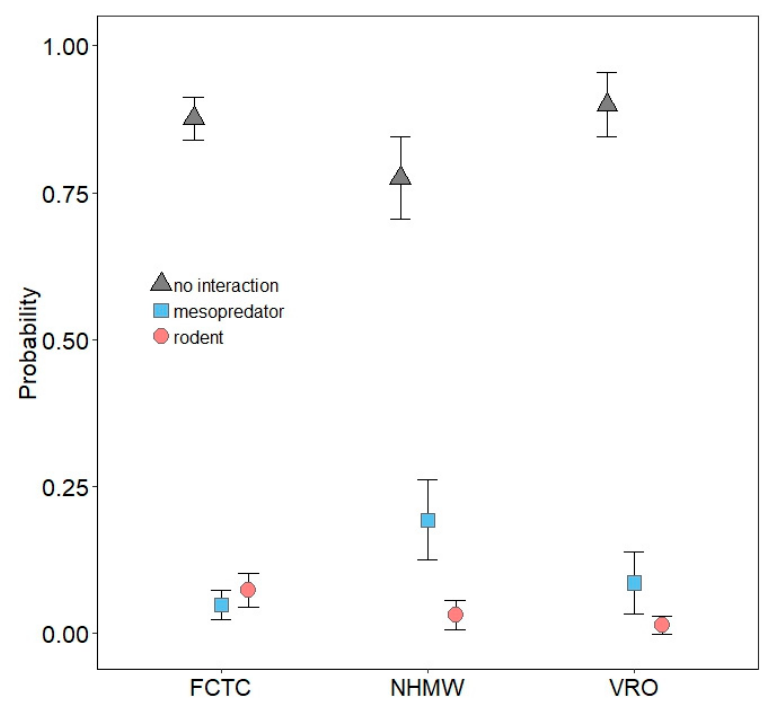
Figure 5. Probability with 85% confidence interval of mesopredators and rodents interacting with three-dimensional printed turtle models (or no interaction) at three study sites: Fort Custer Training Center (FCTC), Michigan, and Nettie Hart Memorial Woods (NHMW) and Vermilion River Observatory (VRO), Illinois, USA.